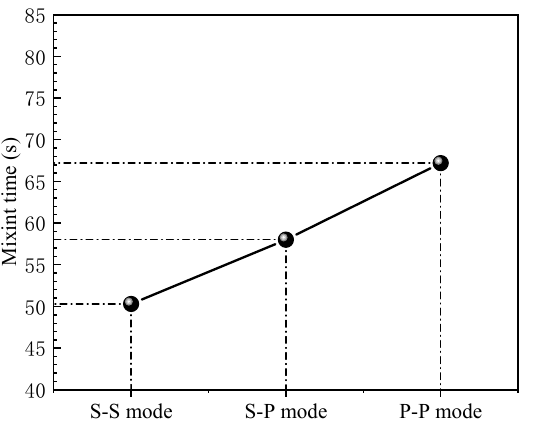
Figure 14. The Comparison of mixing time of bottom ‐ stirring with different plugs (Arrangement for injection and detection point can be seen in Figure 4).